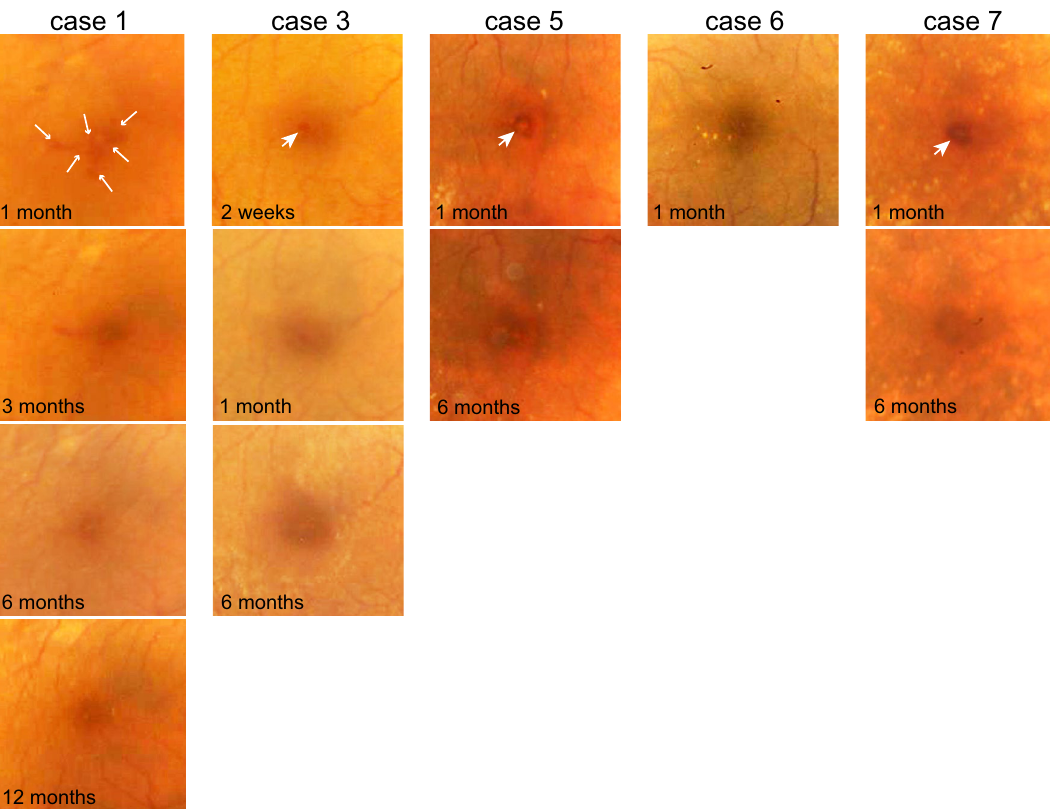
Figure 3. Serial postoperative fundus photographs show hemorrhagic staining at the fovea after surgery (arrows) that was absorbed during follow-up in cases 1, 3, 5, and 7. In case 6, hemorrhagic staining was not observed 1 month after